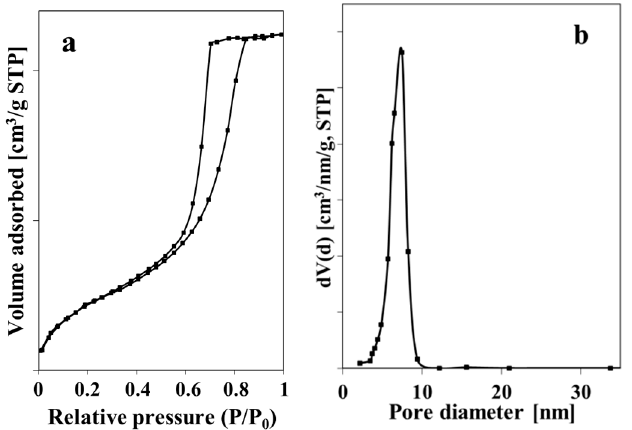
Figure 2. N 2 adsorption–desorption isotherm ( a ) and particles size distribution ( b ) of ZnO NPs.